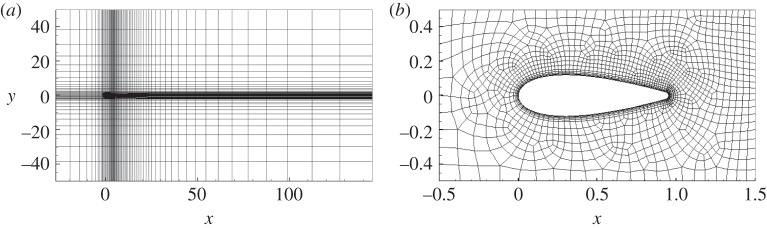
Spectral element decomposition of the computational domain around the modified NACA0024 aerofoil. (a) The whole domain and (b) the subdomain close to the aerofoil.